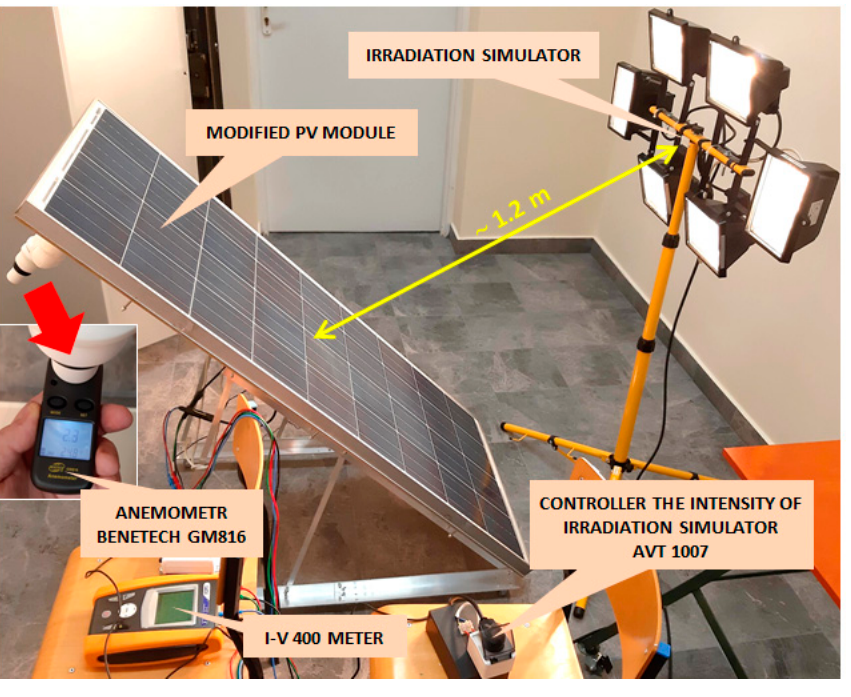
Figure 4. Photograph of the test stand with a presentation of the used measuring instruments.